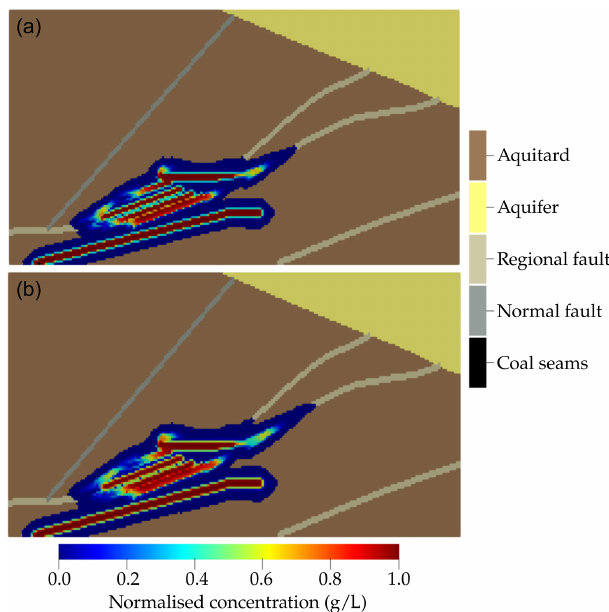
Figure 5. Spatial concentration of contaminant simulated for the reference case after a simulation time of 30 years (a) and 50 years (b) .